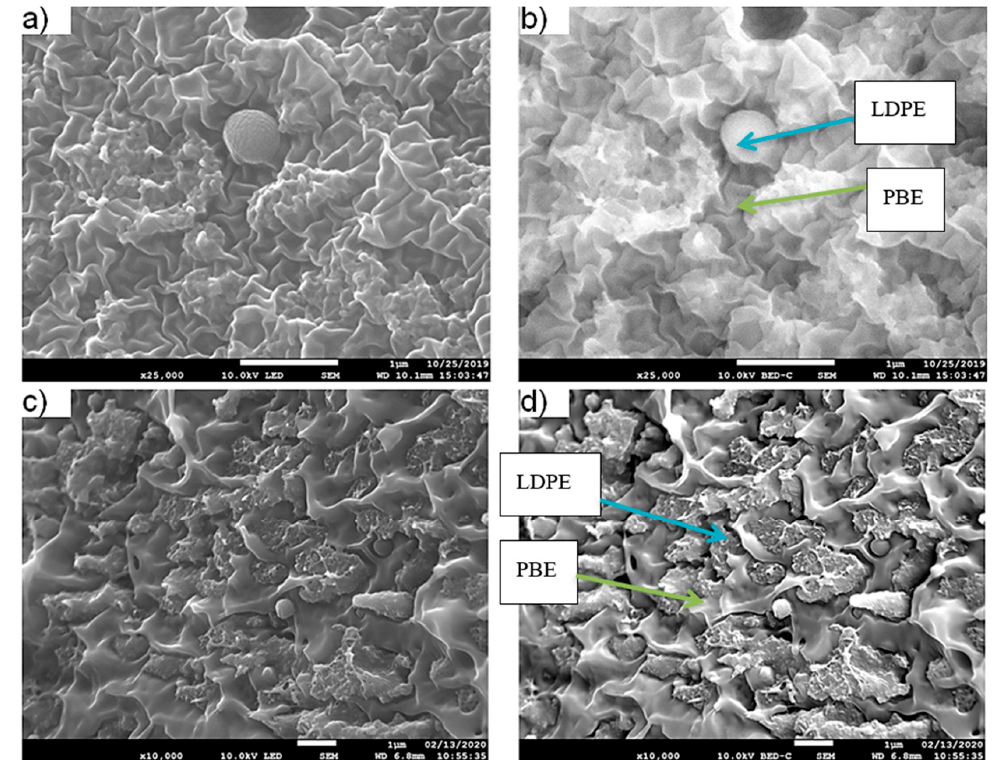
Figure 8. SEM images of the 40 ( LDPE KB 10 ) /60PBE blend in the transverse ( a , b ) and longitudinal directions ( c , d ). ( a , c ) are in normal LED mode and ( b ) and ( d ) are in backscattered mode. LDPE is whiter and the PBE is darker.